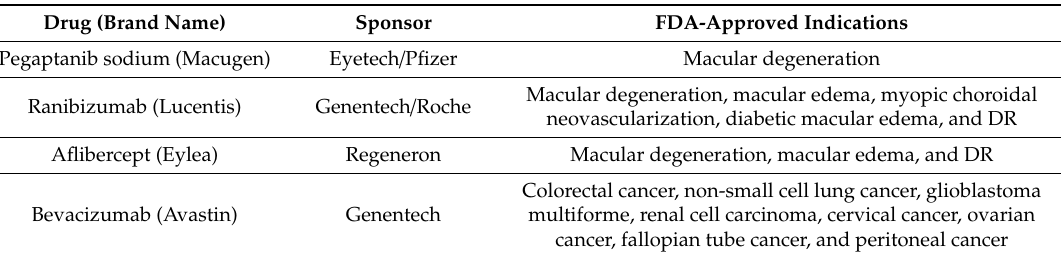
Table 1. Current anti-VEGF